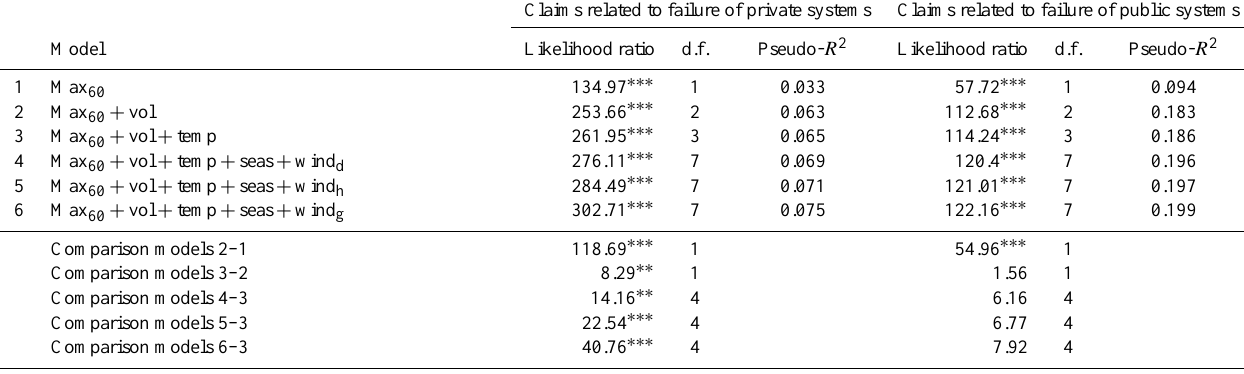
Table 5. Goodness-of-fit measures of logistic regression models.